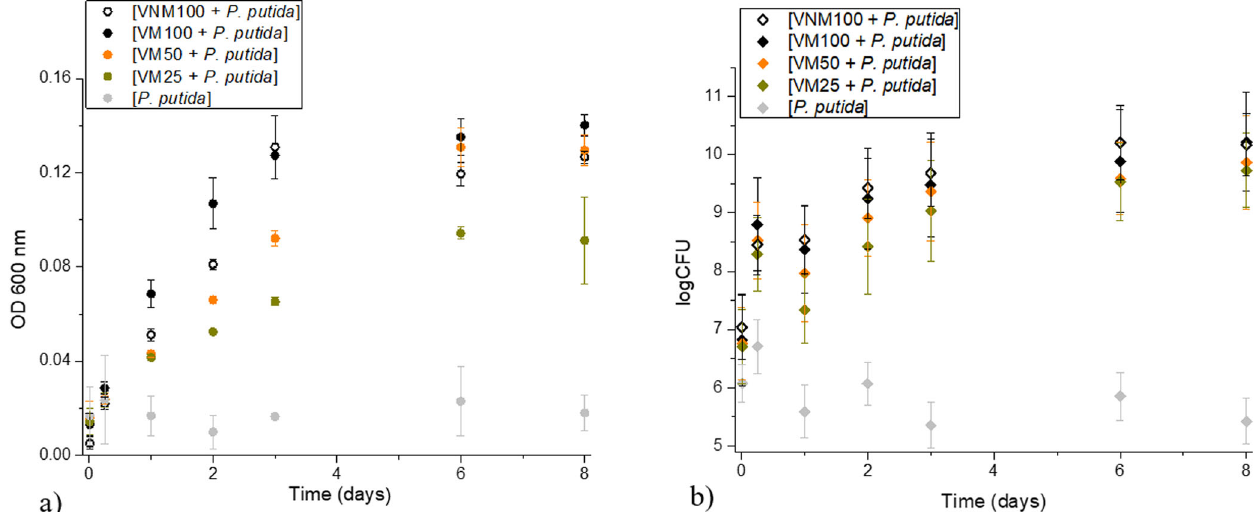
Fig. 2 Bacterial growth curves for all the biotic conditions tested. a Optical density measurements at 600 nm and b plate counting measurements. Uncertainty bars for the OD measurements correspond the standard deviation for the two set of experiments. Uncertainty bars for the CFU take into account both the standard deviation for the two set of experiments and the analytical error on the counting procedure. The R2 calculated by plotting the OD measurements versus the CFU measurements (data in SM) varies between 0.8 and 0.9.